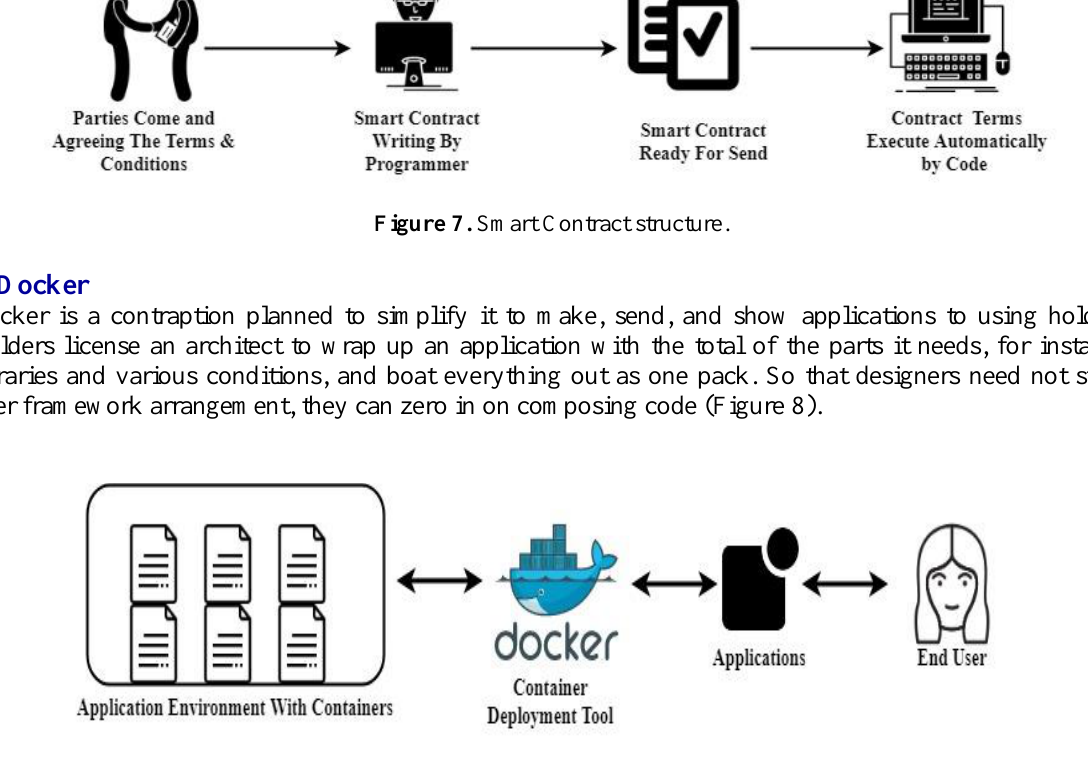
Figure 8. Container deployment